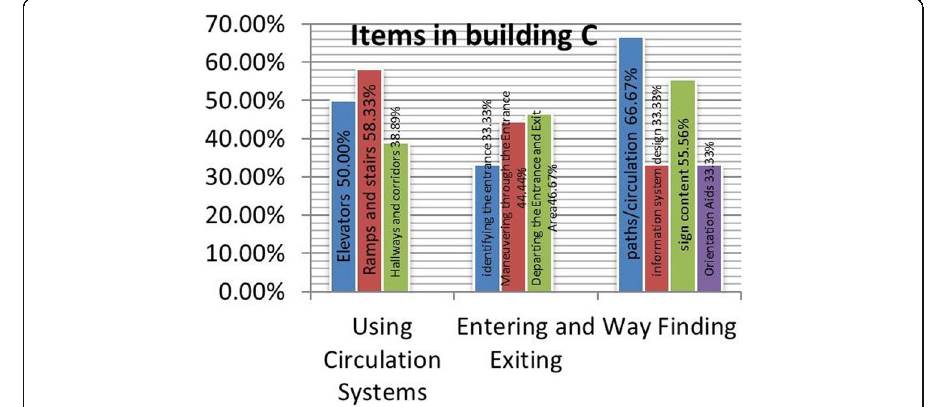
Fig. 22 Percentage of compliance to UD for the elements in building